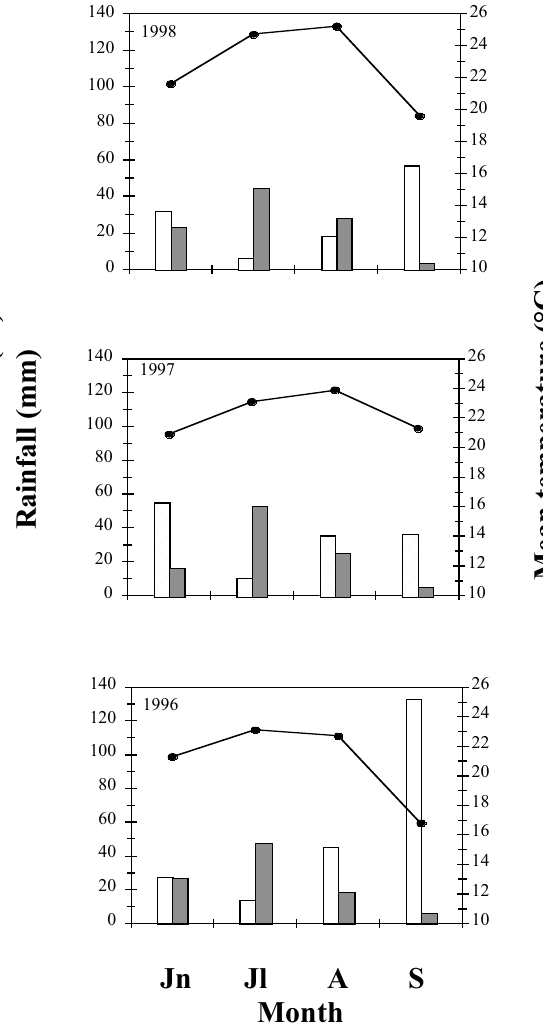
Fig. 6. Esca incidence ( (cid:1) ), mean monthly temperature ( (cid:2) ) and rainfall ( (cid:3) ) in June (Jn), July (Jl), August (A) and September (S) 1996-1998 in a vineyard at Gam- bassi Terme